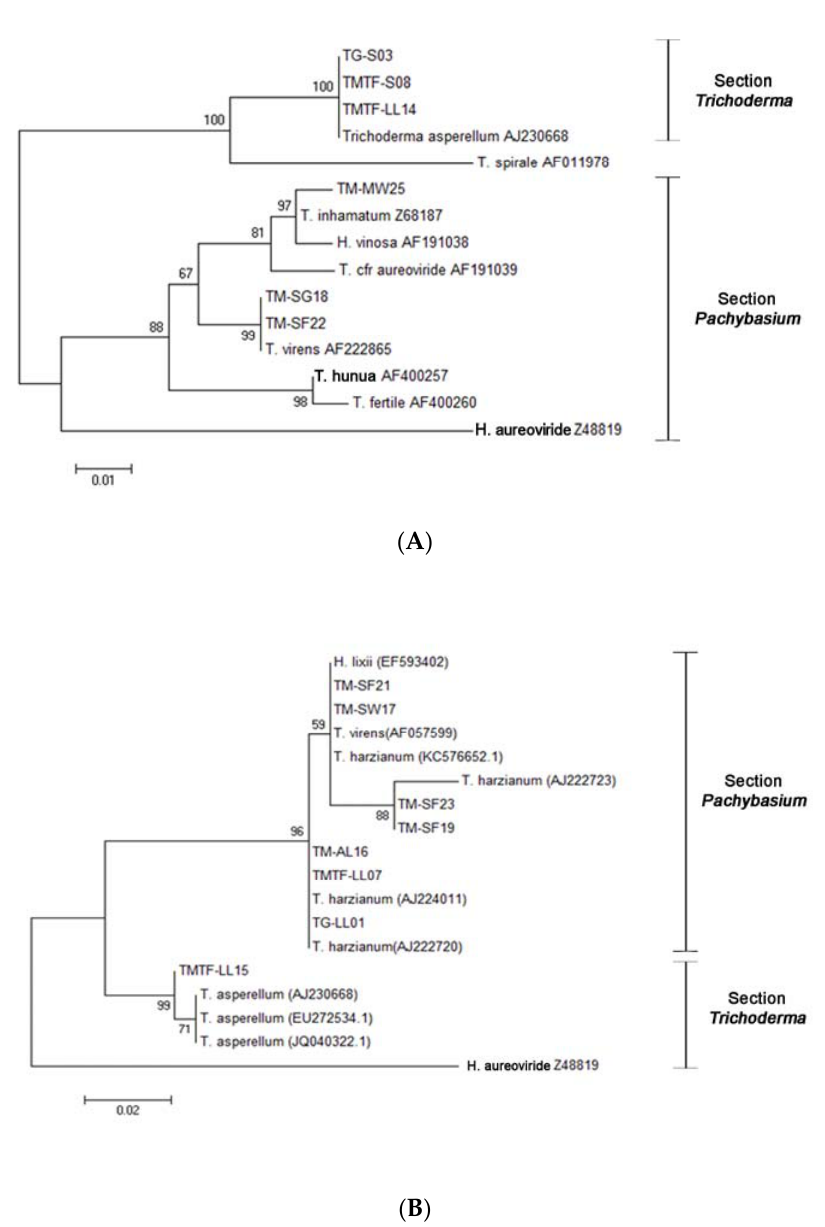
Figure 2. Maximum likelihood tree for the isolated Trichoderma : ( A ) ITS1 and ITS4 sequence analysis using the Kimura 2-parameter model. Substrates and isolate code were as follows: soil (TG-S03 and TMTF-S08), leaf litter (TMTF-LL14), marine water (TM-MW25), seagrass (TM-SG18), and sea foam (TM-SF22). ( B ) ITS5 and ITS4 sequence analysis using the Kimura 2-parameter model. Substrates and isolate code were as follows: sea foam (TM-SF21, TM-SF23, and SM-SF19); seaweed (TM-SW17); aerial leaf litter (TM-AL16); and leaf litter (TMTF-LL07, TG-LL01, and TMTF-LL15). Related sequences were obtained from GenBank and Lieckfeldt et al. [31]. Trichoderma aureoviride Z48819 serves as the outgroup.